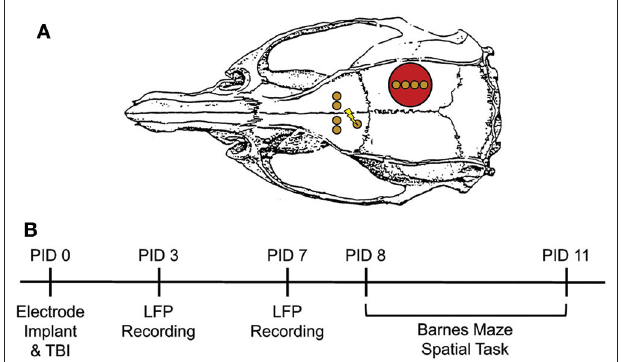
FIGURE 1 | Experimental Design. (A) Electrode configuration and craniotomy location for all animals. Red circle = site of craniotomy/injury. Gold circle = electrode implantation site. Lightning bolt = stimulating electrode pair. (B) Experimental Timeline. Electrodes were immediately implanted following FPI